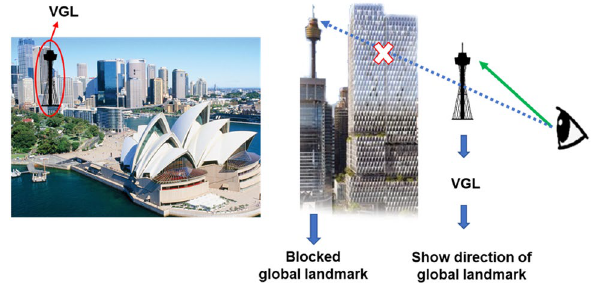
Figure 1. Working mechanism of the VGL system. When the selected global landmark reference is obscured from view, the VGL is displayed to constantly indicate its